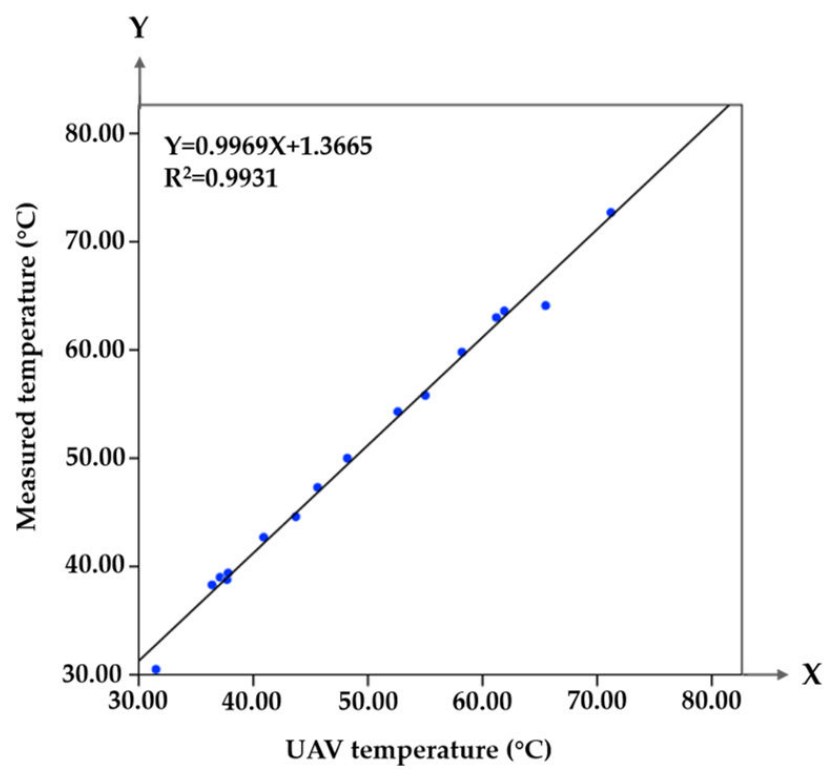
Figure 12. Relationship between UAV temperatures and ground measured